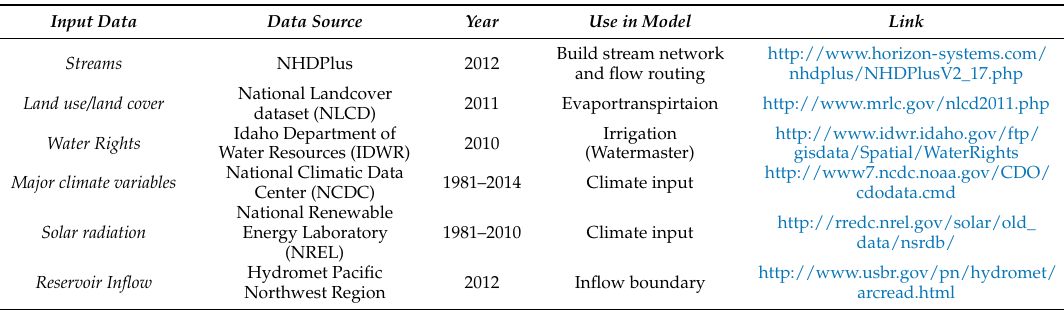
Table 3. Datasets used and the source link in the study.